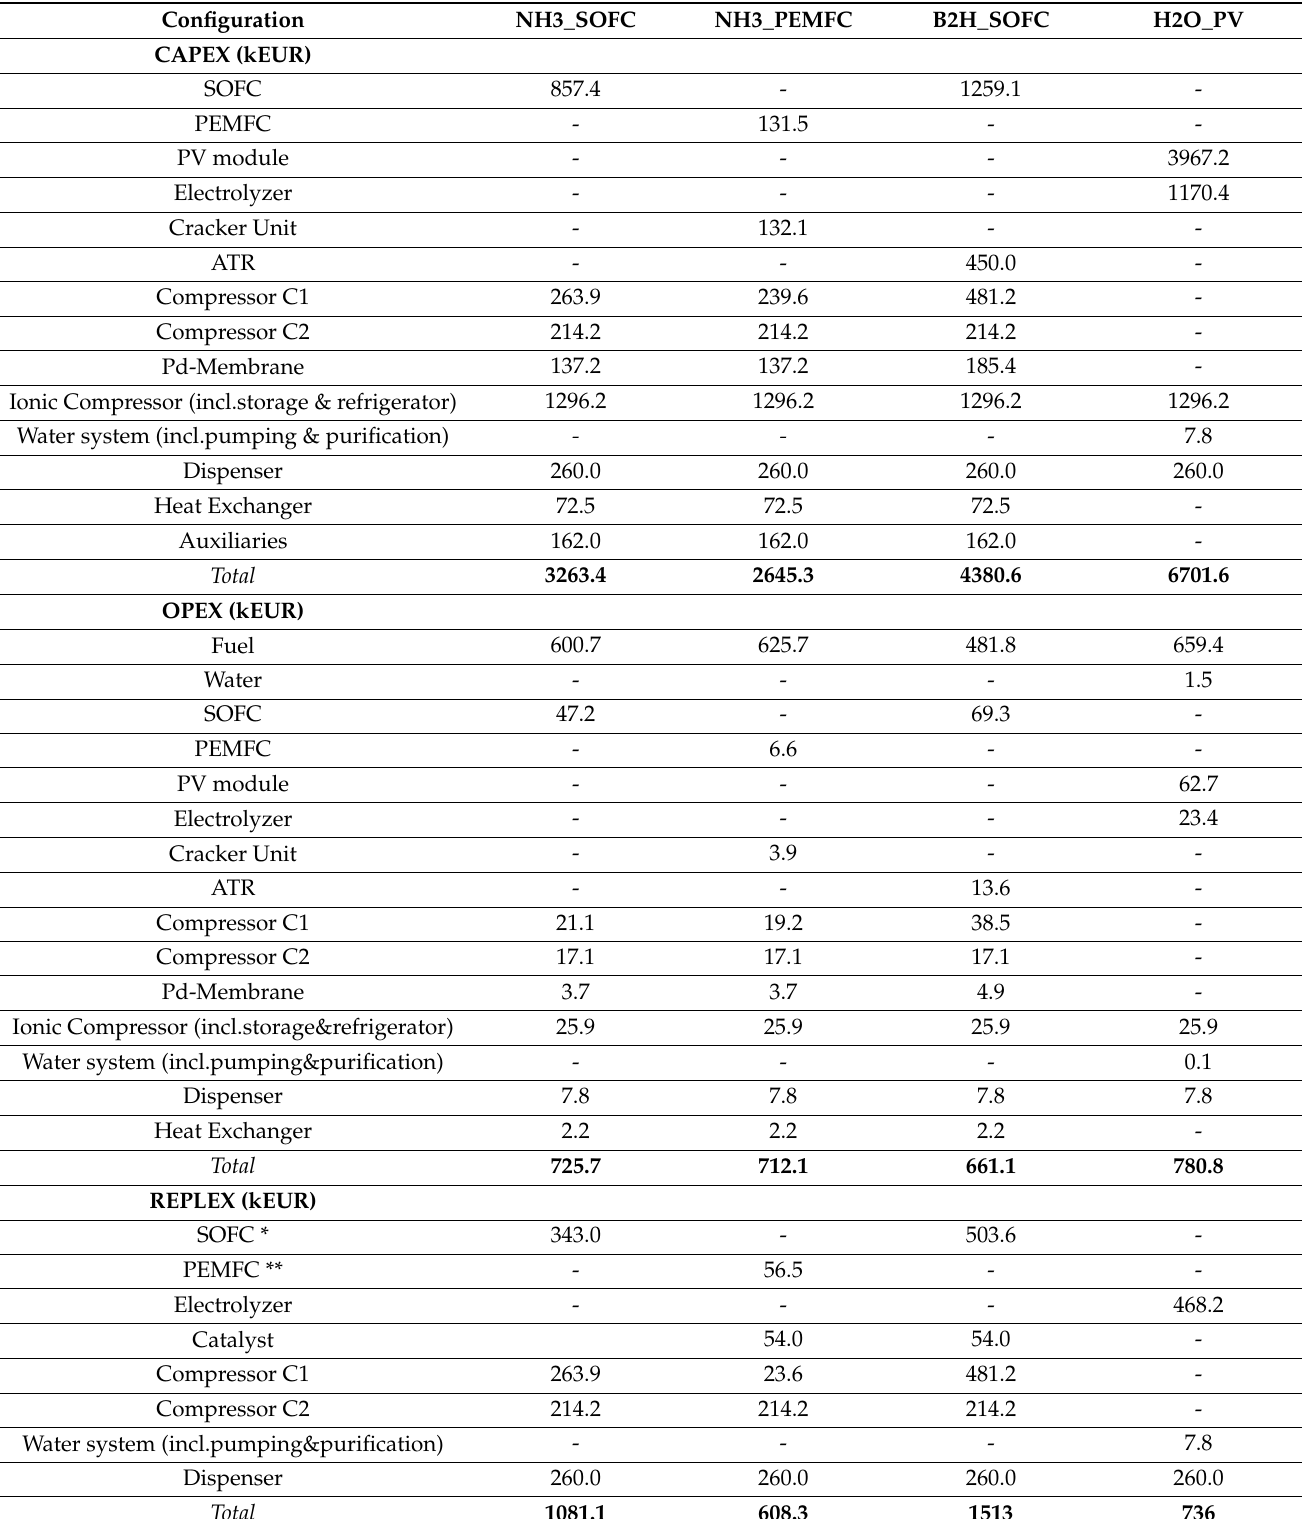
Table A4. Total CAPEX, OPEX and REPLEX for each proposed plant